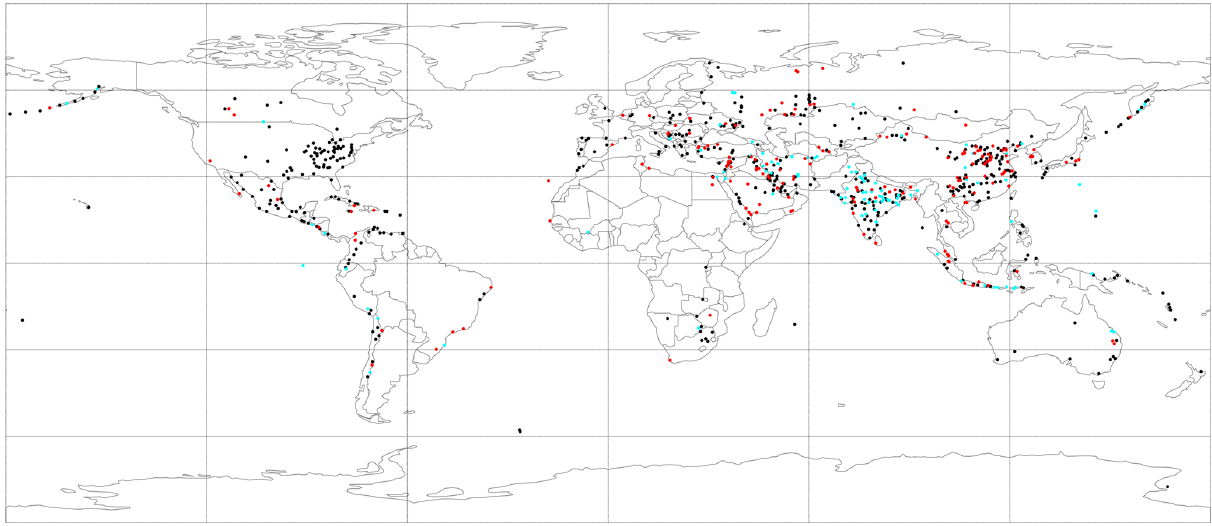
Figure 6. Map of the sources included in the version 2 catalogue. The sources included in the original publication (Fioletov et al., 2016) are shown as black dots, the sources added to the catalogue in 2017–2019 are shown as blue dots, and sources added in the version 2 catalogue are shown as red